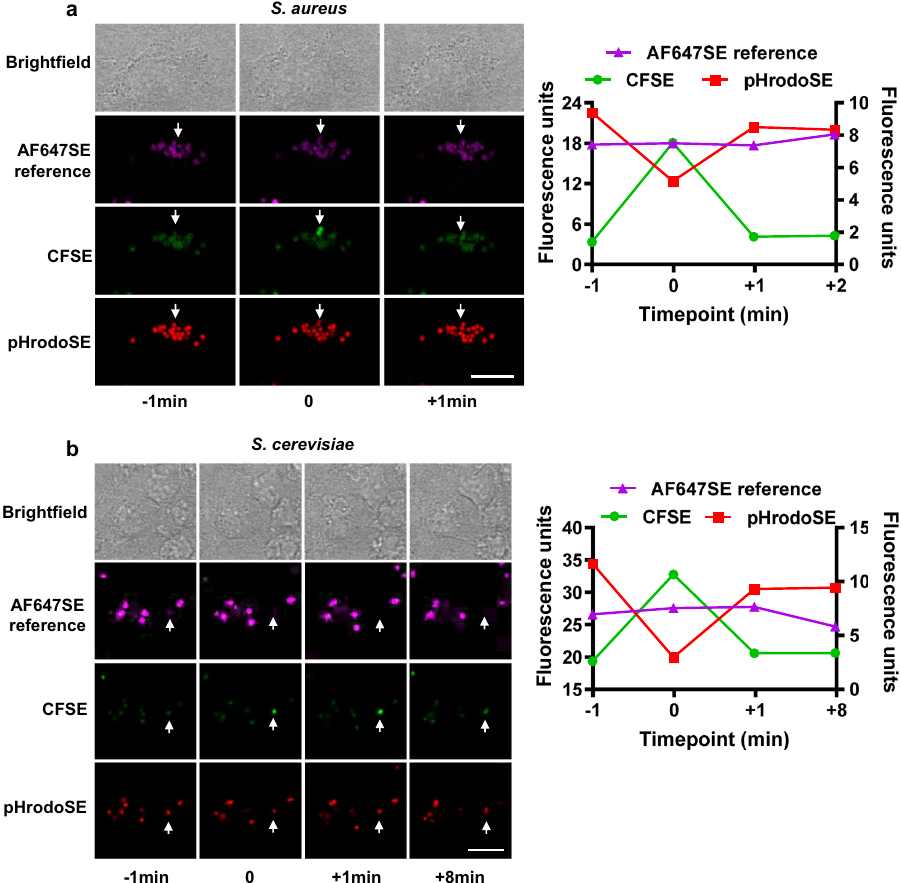
Fig. 1 Transient neutralization of phagolysosomal lumenal pH after phagocytosis of bacteria and yeast. Representative sequential images and corresponding fl uorescent trace diagrams of BMMØs following the phagocytosis of paraformaldehyde- fi xed a Staphylococcus aureus , b S. cerevisiae labelled with the pH-sensitive fl uors CFSE (green) and pHrodoSE (red) and the reference fl uorophore AF647SE (magenta). Transient neutralization of phagolysosomes was demonstrated by concomitant increase in CFSE fl uorescence (green) and loss of pHrodoSE fl uorescence (red), followed by re- acidi fi cation of the phagolysosomal lumen. CFSE and pHRodoSE are plotted on the right axis. AF647SE reference is plotted on the left axis. Images were captured using a Leica SP5 confocal microscope between 45 min and 3 h post-phagocytosis at 37 °C. Time 0 represents a neutralization event. Scale bar denotes 5 μ m. Source data are provided as a Source Data fi